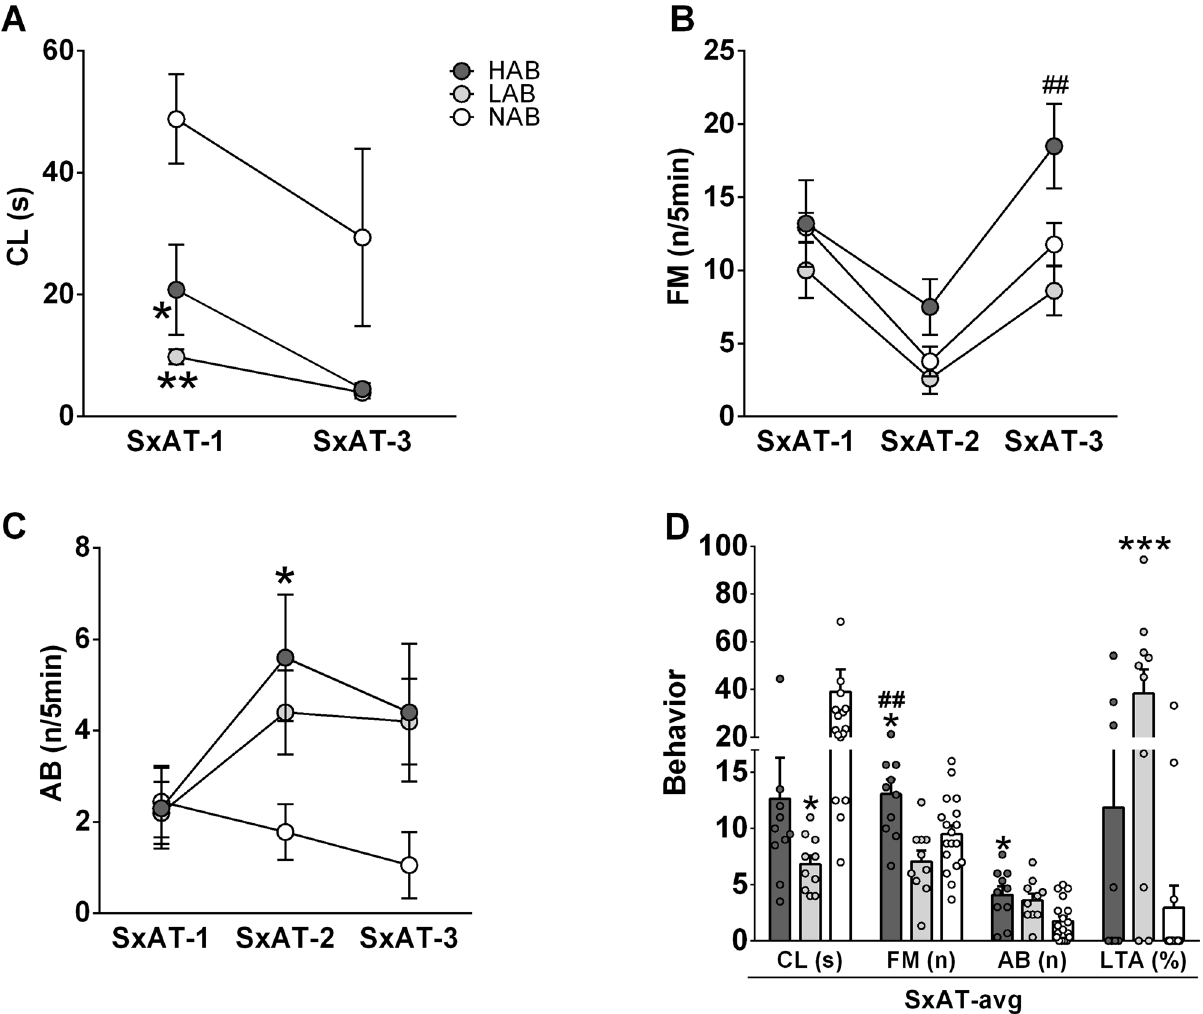
Fig. 2 Behavioral pro fi le of adult male HAB (dark-gray circles and bars), LAB (light-gray circles and bars) and NAB (white circles and bars) rats in three consecutive daily sexual aggression tests (SxAT-1/2/3). A Latency to copulate (CL) with a receptive female rat in SxAT-1 and SxAT-3 (note that SxAT-2 did not have an arousal phase). B Frequency of forced mounts (FM), and ( C ): Frequency of aggressive behaviors (AB) toward a non-receptive female in SxAT-1/2/3. D CL, FM, AB, and the proportion of lateral threats and attacks in AB (LTA%), averaged over SxAT1/2/3. Data are presented as mean ± s.e.m. * p < 0.05, ** p < 0.01, *** p < 0.001 vs. NAB. ## p < 0.01 HAB vs. (Fig. 1H). Moreover, a signi fi cant negative correlation between averaged copulation latency and forced mounting as well as aggressive behavior scores was found (Fig. 1I). Experiment 3: Pharmacological manipulation of SxA Statistics for experiment 3 are summarized in Table 3. Experiment 2: SxA in HAB, LAB, and NAB rats Statistics for experiment 2 are summarized in Table 2. HAB, LAB, and NAB rats differed in their levels of anxiety-related behavior on the EPM with HAB rats being the most anxious (% of time in open arms: 5.07 ± 1.17%), followed by NAB rats (32.35 ± 3.64%) and LAB rats (60.33 ± 3.78%). In the SxAT, HAB males showed the highest forced mounting score, which differed signi fi cantly from LAB males in SxAT-3 (Fig. 2B) and from both LAB and NAB males in the average of all SxAT (Fig. 2D). HAB rats also showed the highest aggressive behavior score, which differed signi fi cantly from NAB, but not LAB, rats in SxAT-2 (Fig. 2B, note that this was the test without arousal phase) and in the average of all SxATs (Fig. 2D). NAB rats showed the longest copulation latency, which differed signi fi cantly from both HAB and LAB rats in SxAT-1 (Fig. 2A) and from LAB rats (but not HAB rats) in the average of SxAT-1 and SxAT-3 (Fig. 2D). The